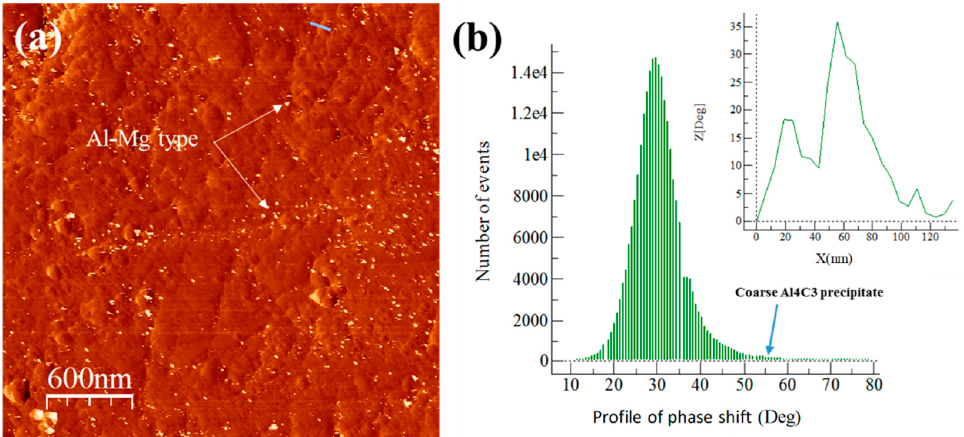
Figure 12. Al / C composite: ( a ) AFM tapping mode image and ( b ) degree distribution profile of the Figure 12. Al/C composite: ( a ) AFM tapping mode image and ( b ) degree distribution profile of the Figure 12. Al/C composite: ( a ) AFM tapping mode image and ( b ) degree distribution profile of the Figure 12. Al/C composite: ( a ) AFM tapping mode image and ( b ) degree distribution profile of the phase shift and distribution profile of a corresponding continuous line that crosses the bright area in phase shift and distribution profile of a corresponding continuous line that crosses the bright area in phase shift and distribution profile of a corresponding continuous line that crosses the bright area in phase shift and distribution profile of a corresponding continuous line that crosses the bright area in the phase image (shown inset of the the phase image (shown inset of the figure). the phase image (shown inset of the figure). the phase image (shown inset of the figure).